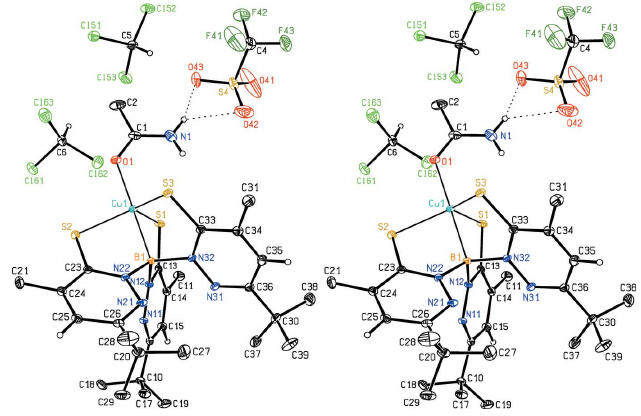
Figure 1 Stereoscopic plot of the molecular structure of the title compound, with the atom labelling and displacement ellipsoids drawn at the 50% probability level. The H atoms of the methyl groups were omitted for clarity and hydrogen bonds are indicated by dotted lines.